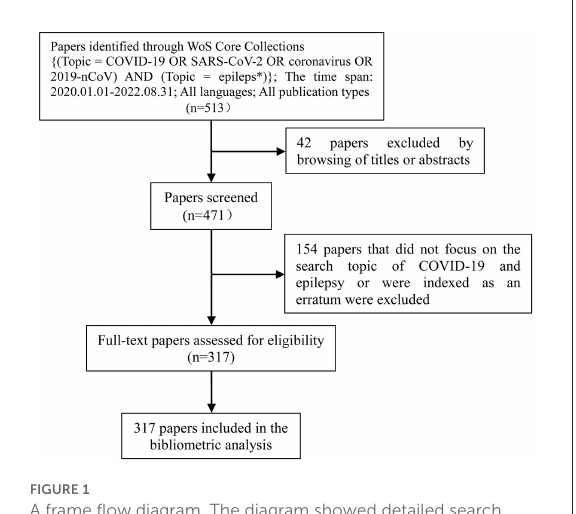
FIGURE1 A frame flow diagram. The diagram showed detailed search strategy and the selection criteria for papers regarding COVID-19 and epilepsy from WoS core